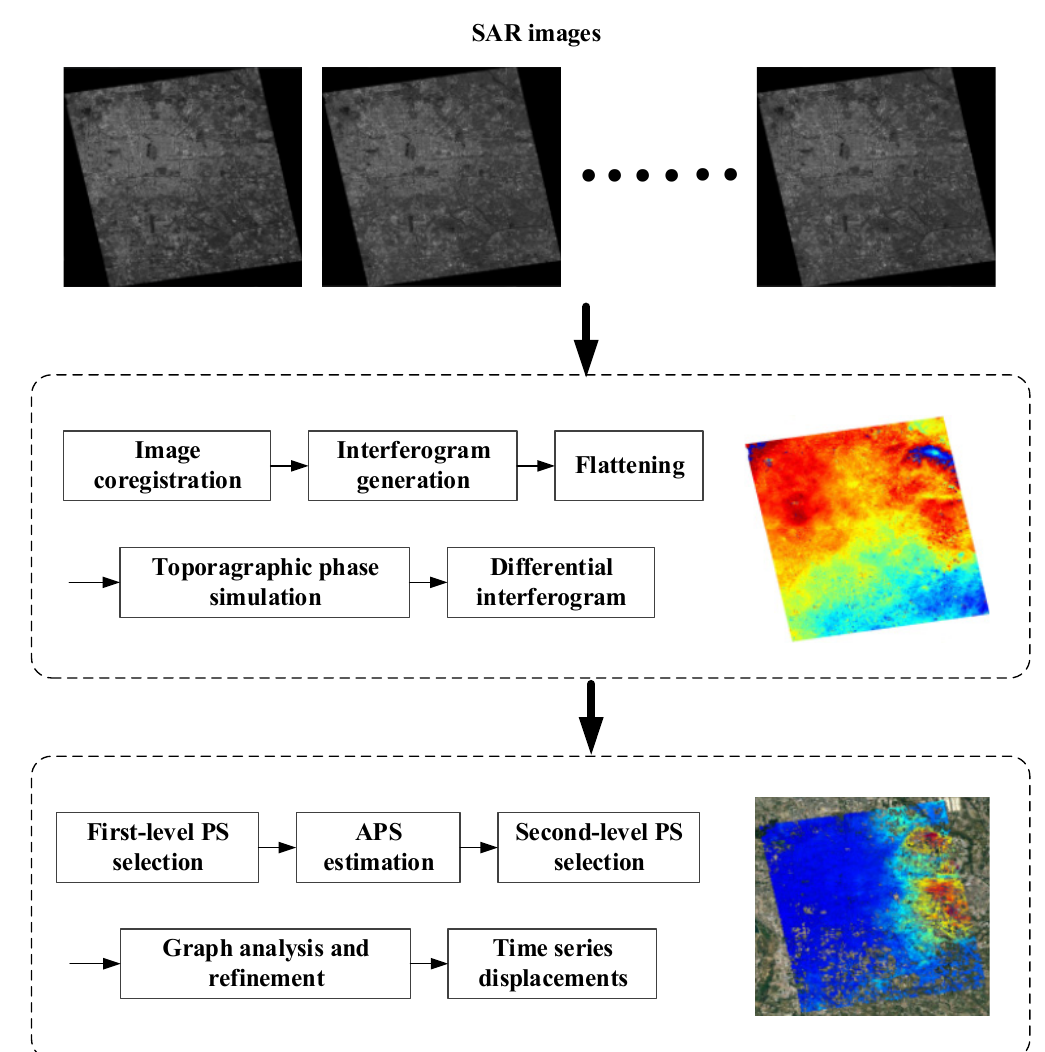
Figure 3. The flowchart of PS-InSAR processing steps.